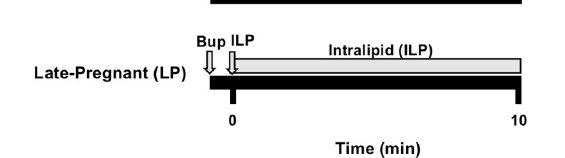
FIGURE1 Experimental protocol. Non-pregnant (NP, n = 6) and late-pregnant (LP, day 20, n = 7) rats were used. Cardiac arrest was induced with bupivacaine (Bup) and immediately followed by resuscitation with intralipid (ILP) bolus followed by infusion and chest compressions for 10-min. EKG was recorded throughout experiment and heart rate (HR), left ventricular ejection fraction (LVEF), and left ventricular fractional shortening (LVFS) were acquired at baseline and